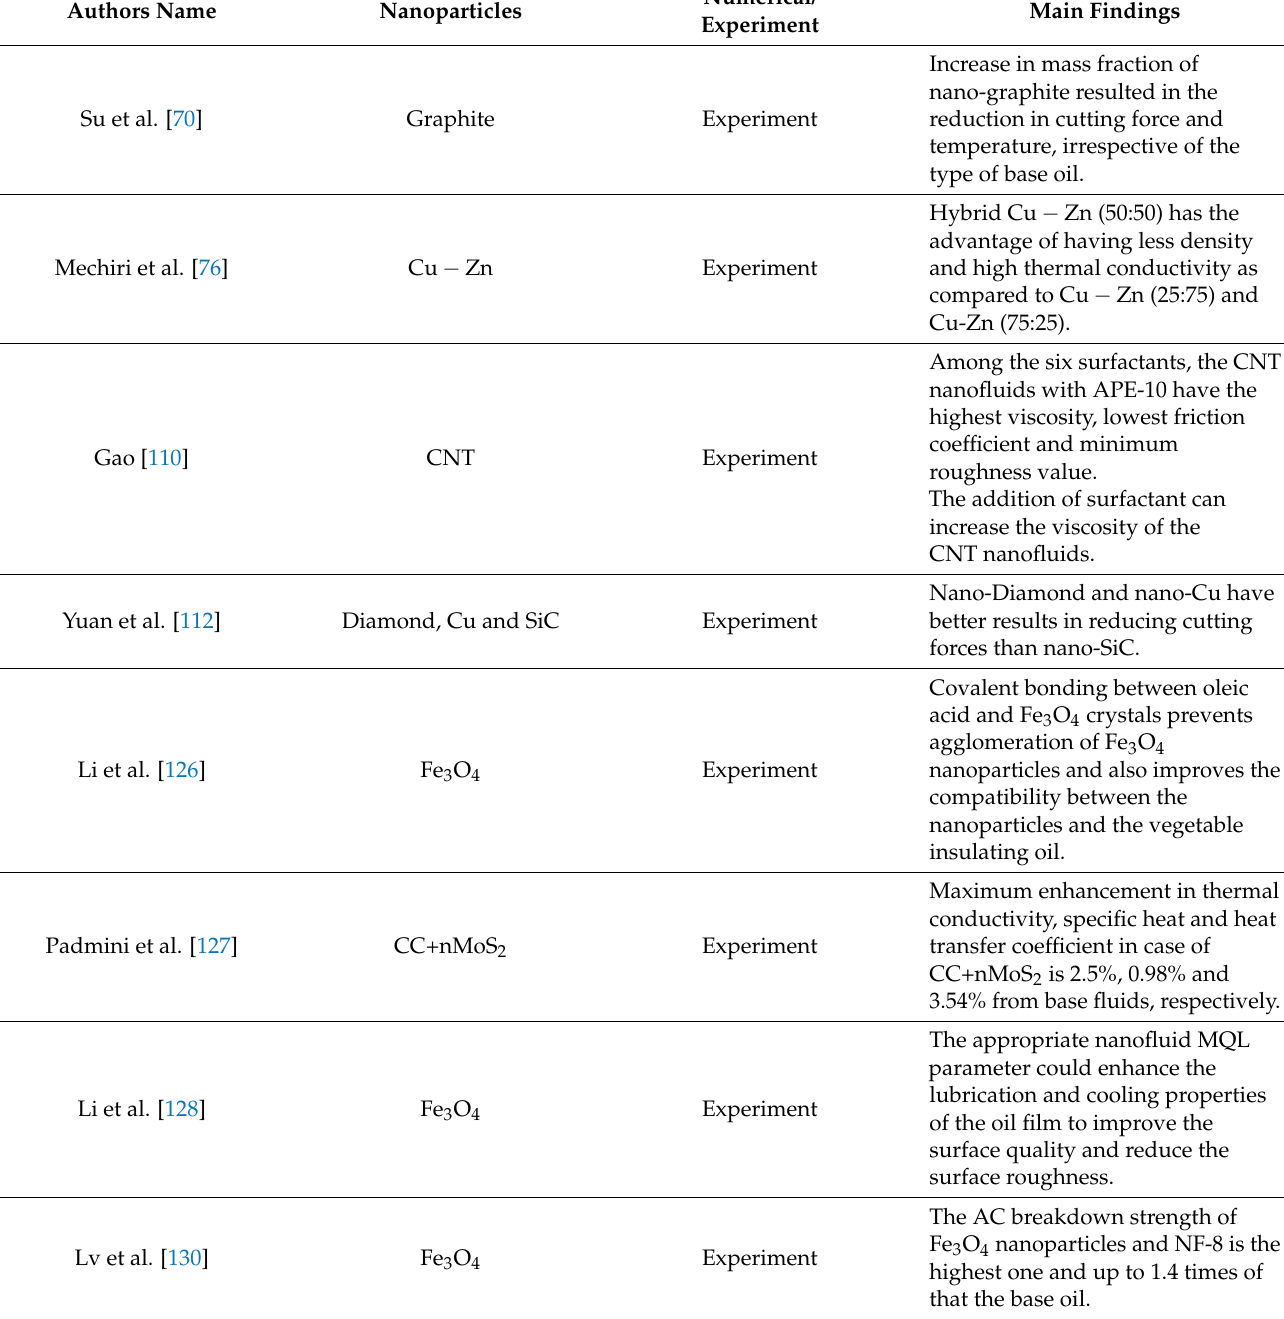
Table 8. Comparison of previous investigations on vegetable-oil-based